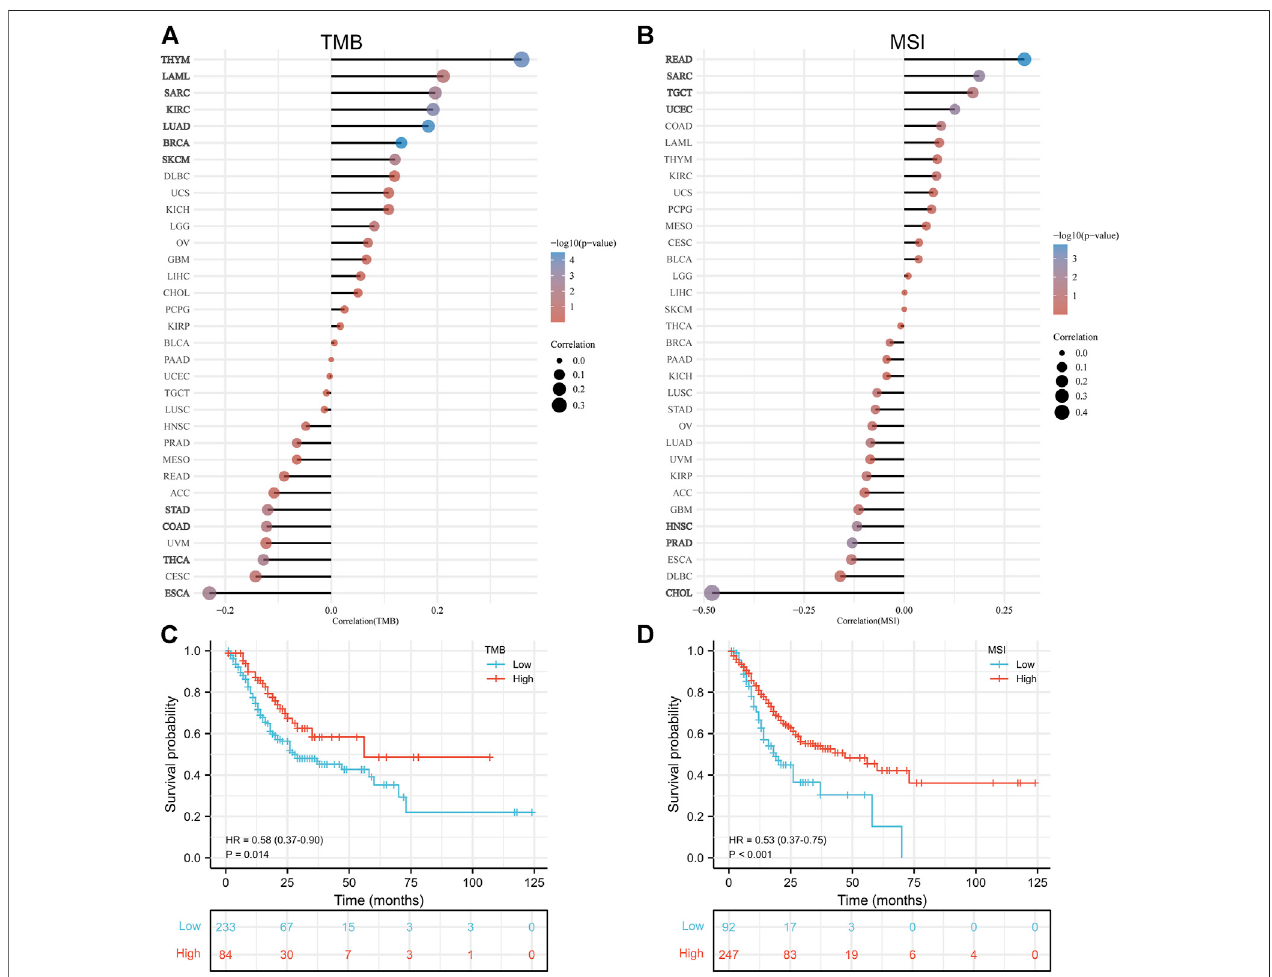
FIGURE 3 | Correlation analysis of PLOD2 expression with tumor mutational burden and microsatellite instability. (A) with TMB (B) with MSI (C) relationship between TMB and overall survival (D) relationship between MSI and overall